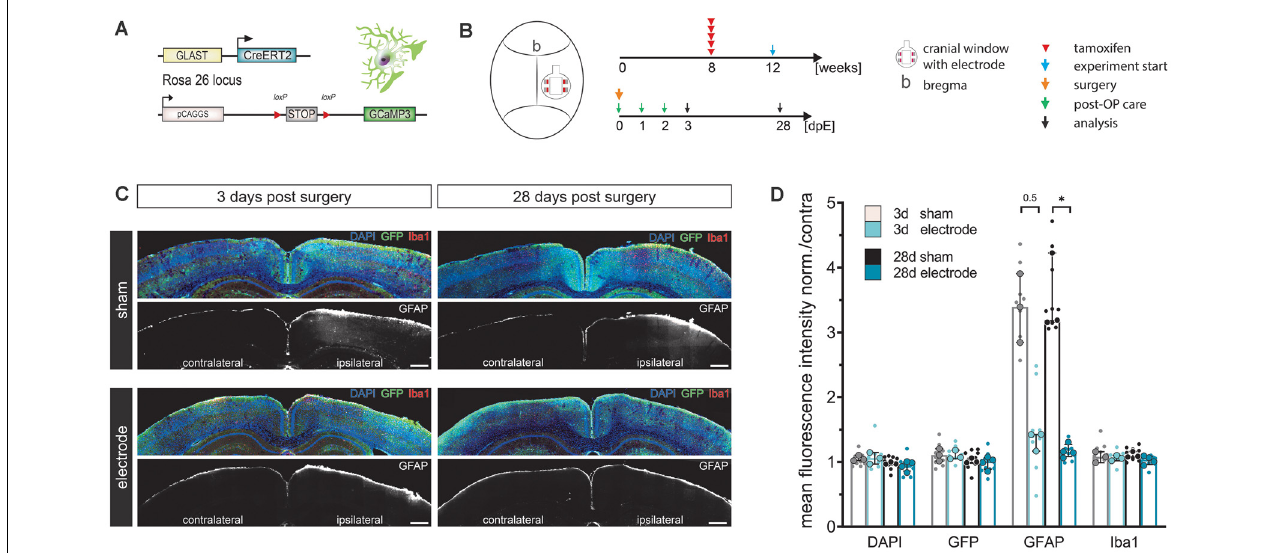
FIGURE 2 | LCP surface electrodes are long-term biocompatible and favorable for in vivo studies. (A) The biocompatibility study was carried out on transgenic mice with tamoxifen-induced, astrocyte-specific GCaMP3 expression. (B) Eight-week-old animals were administered five consecutive i.p. injections of tamoxifen to induce GCaMP3 expression in astrocytes. At 12 weeks of age, animals underwent cranial window surgery with or without (sham) surface electrode implantation. An immunohistochemical analysis was carried out 3 or 28 days post-surgery. (C) Activation of microglia (Iba1) and astrocytes (GFAP) was assessed by immunohistochemical staining of coronal slices. GCaMP3 expression was revealed by GFP immunostaining. Ipsilateral: surgery side, contralateral: control side. Scale bars indicate 500 µ m. (D) Astroglial GFAP reactivity was increased in sham groups compared to electrode implanted groups both 3 and 28 days post-surgery, while the astrocyte activation of the electrode implanted groups was only minimally increased, indicating high biocompatibility and an additional stabilizing effect of the LCP cortical surface electrode. Ipsilateral fluorescence intensity values were normalized to the contralateral side. Statistics: Kruskal–Wallis test followed by Dunn’s multiples comparisons test ∗ p < 0.05. Data are displayed as median with IQR. Larger data points correspond to the average of slices from the same animal, smaller data points indicate individual slices. 3 d sham N (animal) = 3, n (slice) = 9; 3 d electrode N = 3, n = 9; 28 d sham N = 3, n = 9; 28 d electrode N = 4, n =